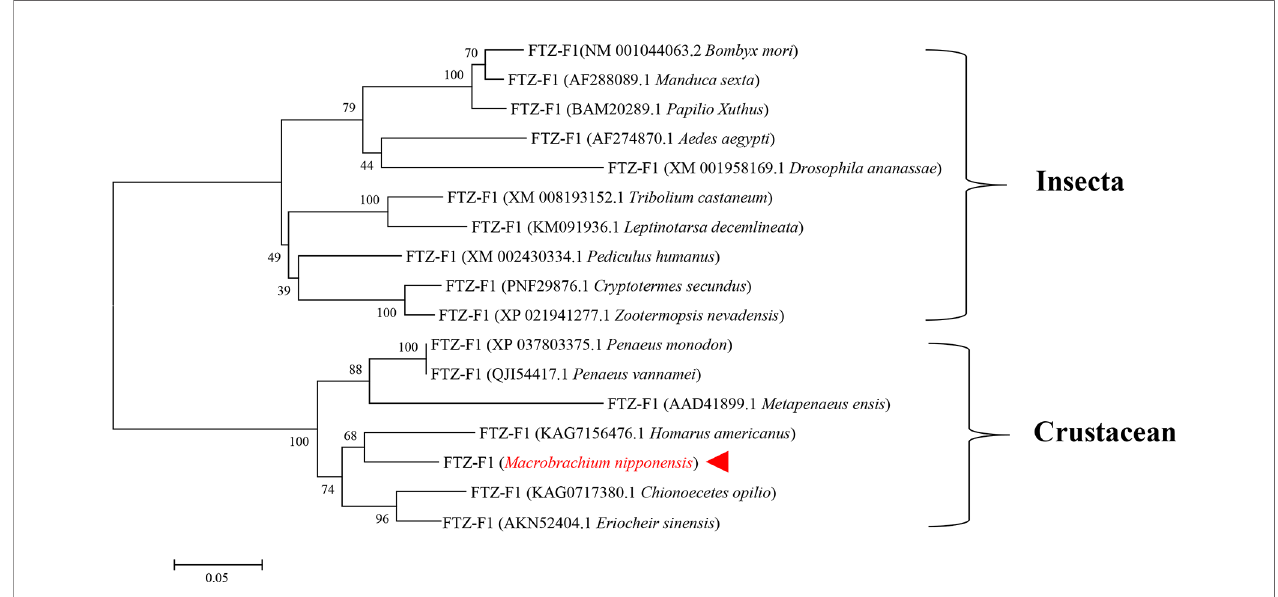
FIGURE 3 | Phylogenetic tree of amino acid sequences of MnFtz-f1 from various species. GenBank accession numbers are shown in brackets. M. nipponense MnFtz-f1 is marked in